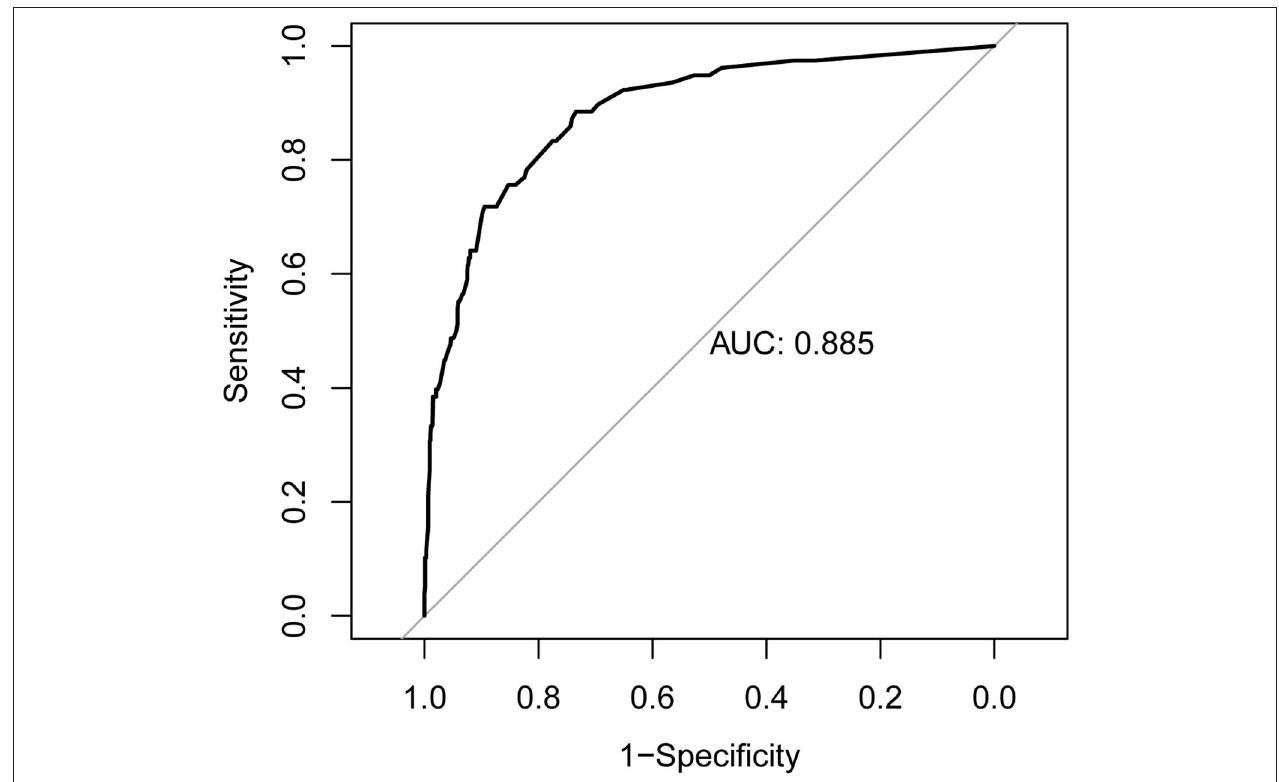
FIGURE 3 | Receiver operating characteristic (ROC) curve of the nomogram. The nomogram had good discriminative power with area under ROC curve of 0.885 (95% CI,